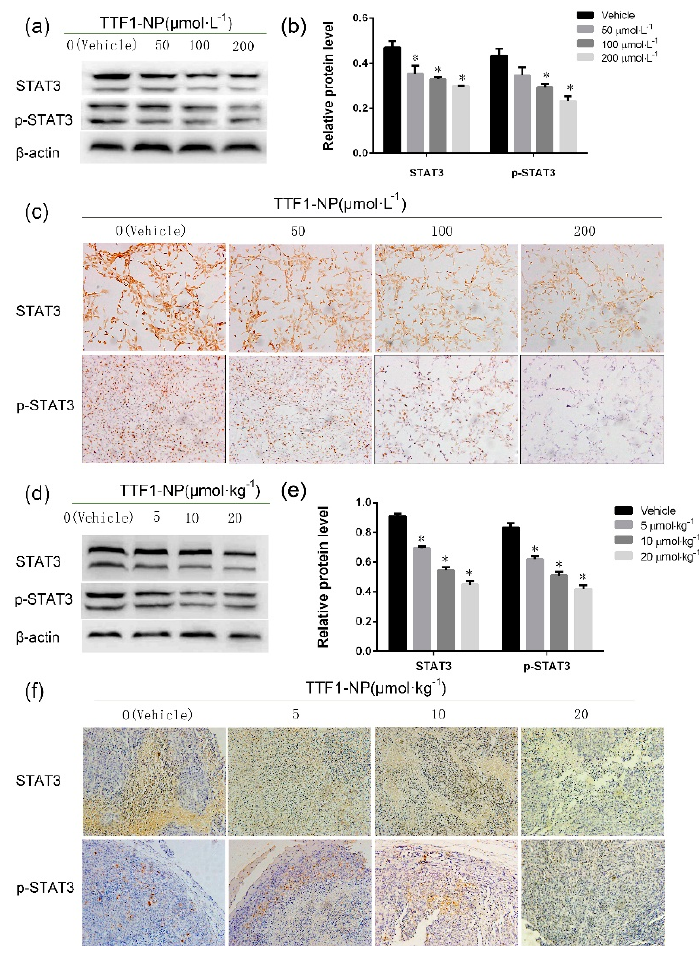
Figure 4. TTF1-NP inhibited expression of STAT3 and p-STAT3 in human hepatoma cells in vitro ( a , b , c ) and in vivo ( d , e , f ). ( a , d ) Western blot analysis of STAT3 and p-STAT3 after TTF1-NP-treatment in ( a ) HepG2 cells and ( d ) nude mice implanted with HepG2 cells; ( b , e ) Quantification of western blot analysis of STAT3 and p-STAT3 protein levels normalized by the levels of β -actin in ( b ) HepG2 cells and ( e ) nude mice implanted with HepG2 cells, data represent mean ± SD of three independent experiments. * p < 0.05 for the designated treatment vs. Vehicle; ( c , f ) Immunocytochemistry of STAT3 and p-STAT3 in ( c ) HepG2 cells and ( f ) nude mice implanted with HepG2 cells after TTF1-NP-treatment (200× magnification).